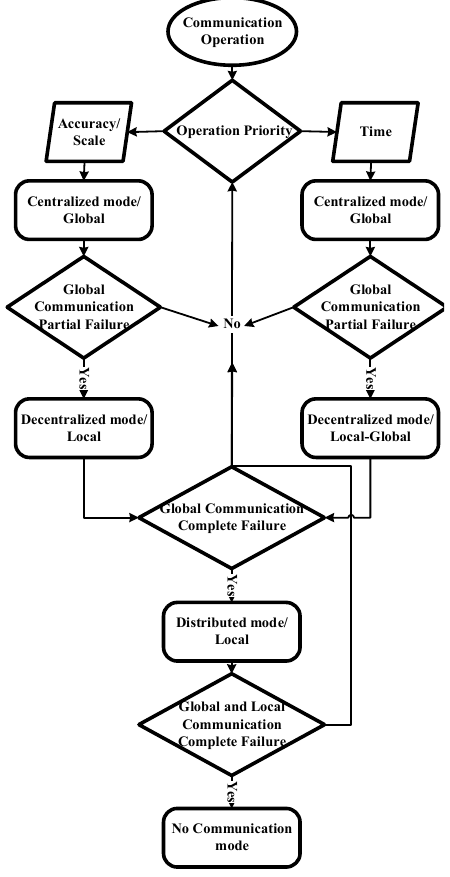
Figure 6. Proposed communication system operation algorithm.